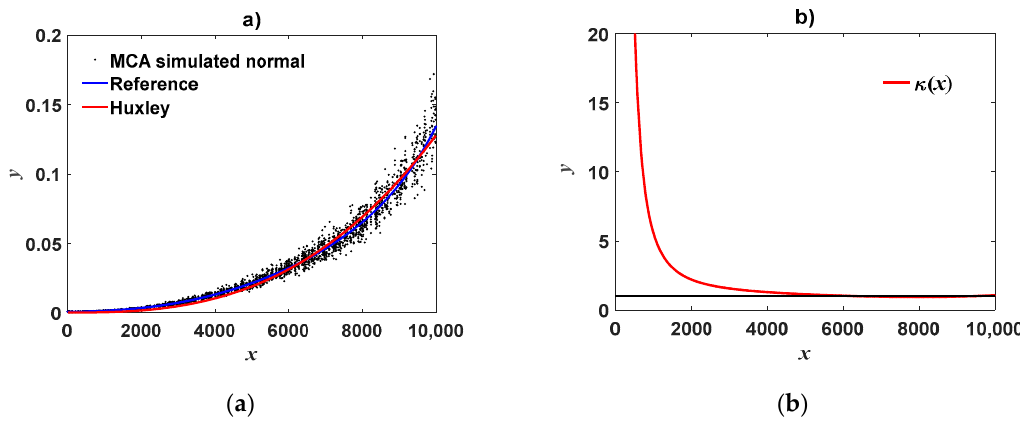
Figure 1. Huxley’s model of simple allometry fitted on multiple-parameter complex allometry (MCA) data simulated based on a lognormal distribution Panel ( a ) displays spread of y k ( i ) ( (cid:15) ) replicates around the reference curve y = ex p ( P 2 ( x )) exp ( Q 2 ( x ) lnx ) compared to the fitted Huxley’s mean response. Panel ( b ) shows the plot of curvature index κ ( x ) . We can ascertain that deviations from linearity in geometrical space can be expected for this data.